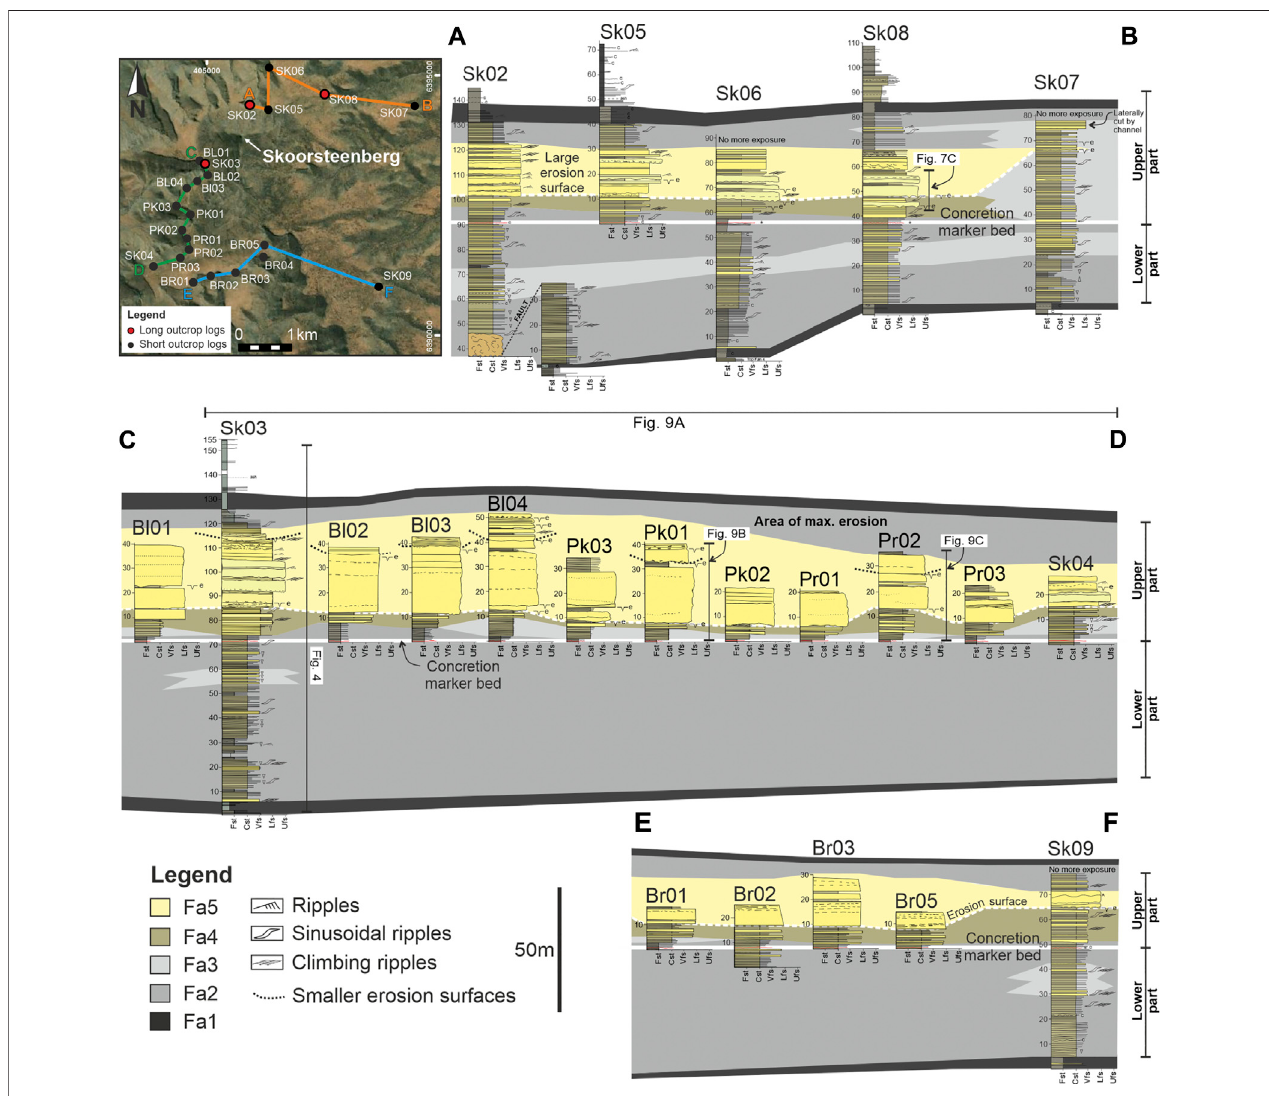
FIGURE6| CorrelationpanelofoutcroplogsofUnit5 fl attenedontheconcretionmarkerbedon(thewhitesolidline).Theerosionsurfaceismarkedbythewhitedashedline with smaller erosion surfaces in the upper part shown by the black dashed lines. Locations of correlation panels A - B , C - D and E - F are shown in the map on the top left.